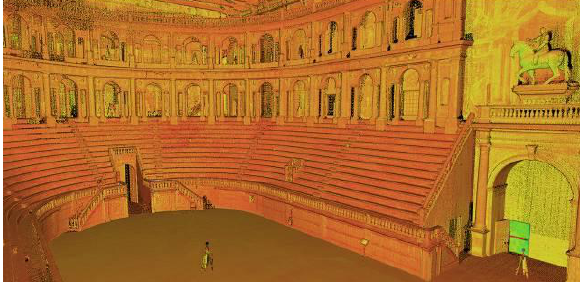
Figure 2 . Point cloud from the laser scanner survey, after registration.